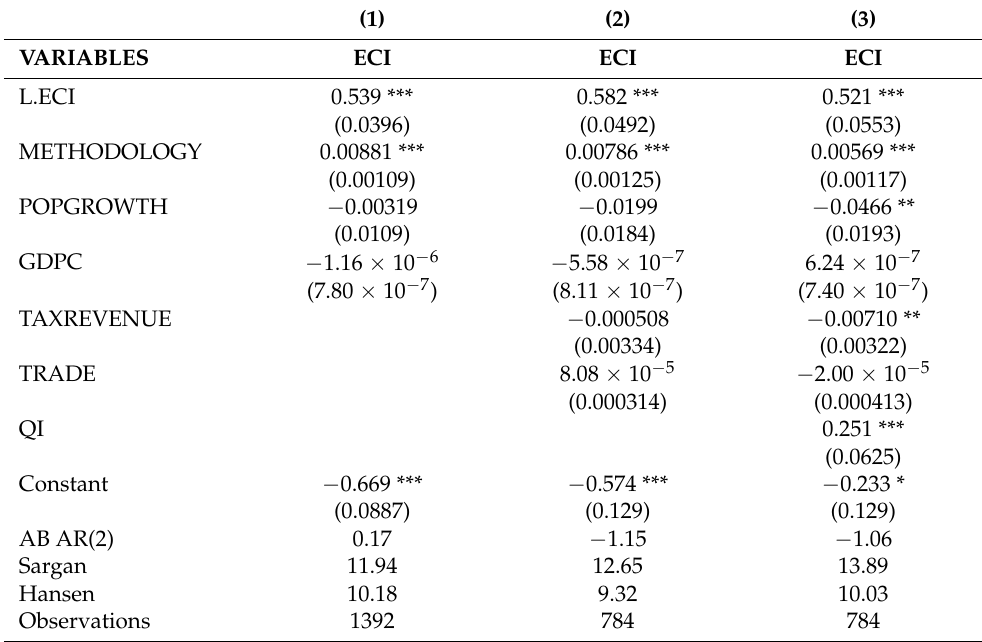
Table 6. Results of regression models (based on methodology assessment of statistical